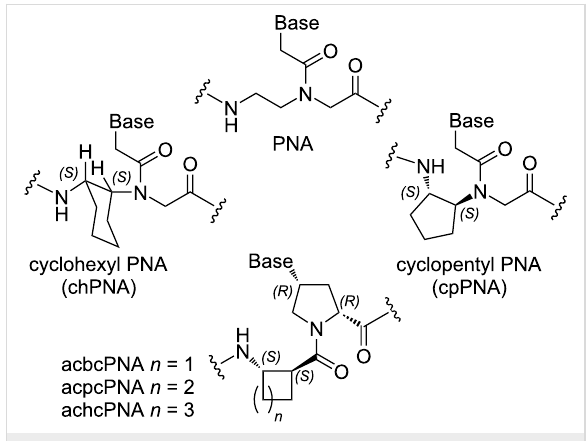
Figure 4: Structures of backbone-modified